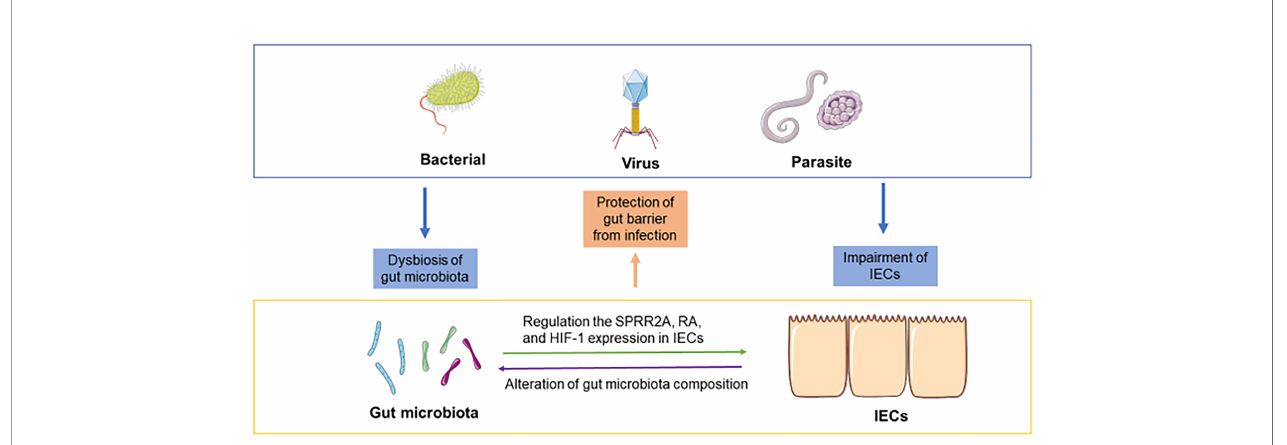
FIGURE 2 | Crosstalk between the gut microbiota and IECs during infection. Bacterial infection, viral infection and parasite infection can induce dysbiosis of the gut microbiota and impairment of the gut barrier. The crosstalk between the gut microbiota and IECs may play an essential role during infection. For instance, the gut microbiota regulates the response to pathogens in IECs by modulating the expression of SPRR2A, RA, and HIF-1. IECs can alter the composition of gut microbiota and contribute to protection against